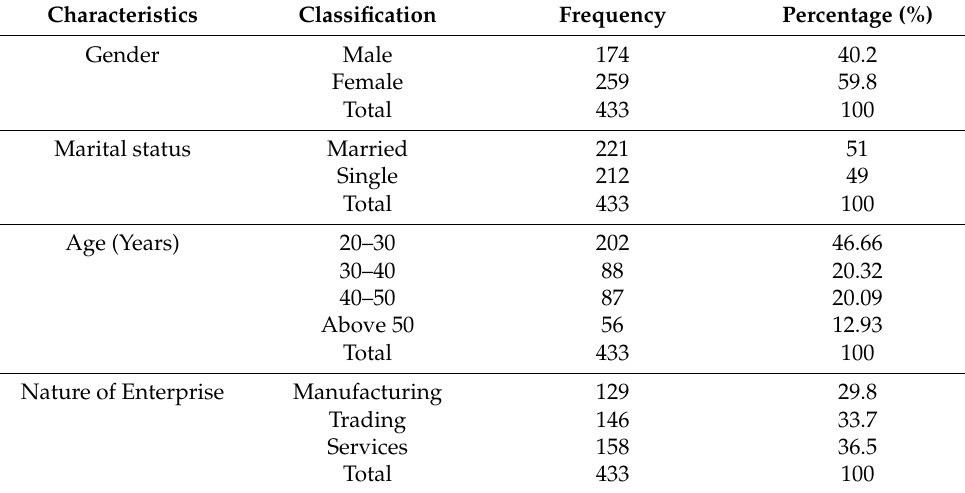
Table 1. Demographic profile of the respondents.